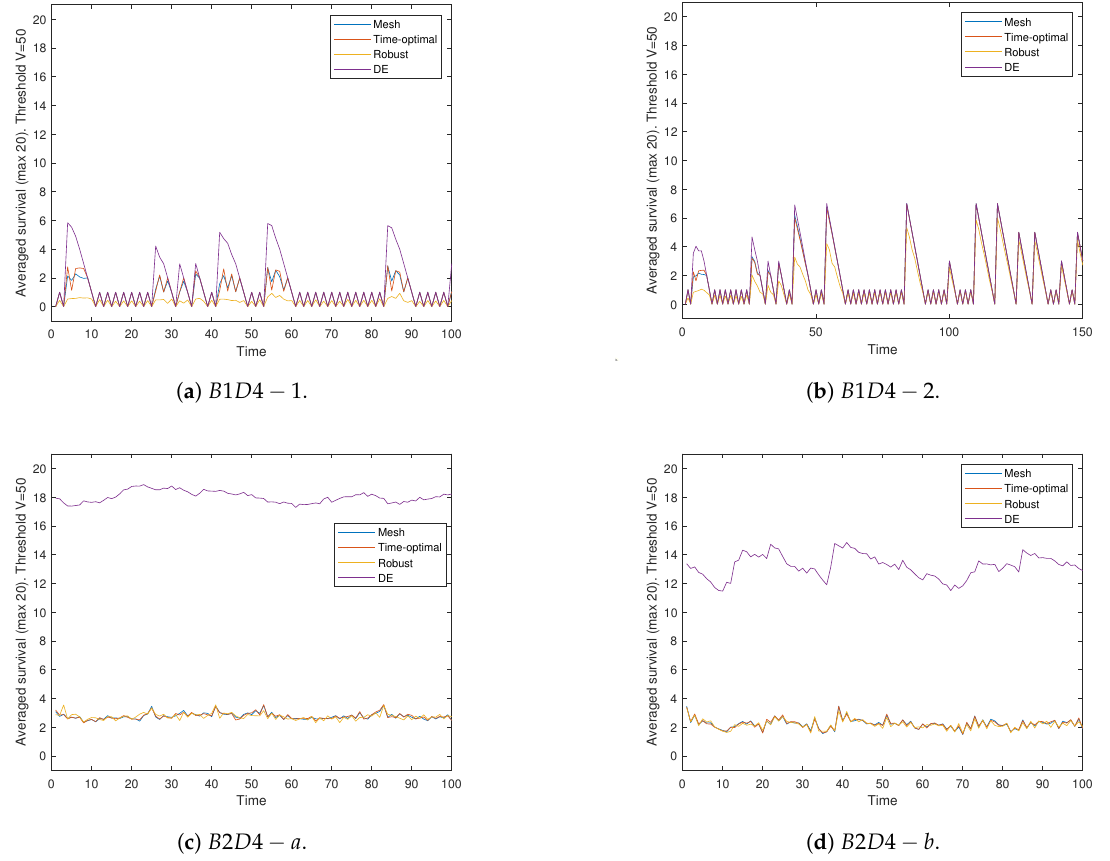
Figure 9. Results obtained using dynamic